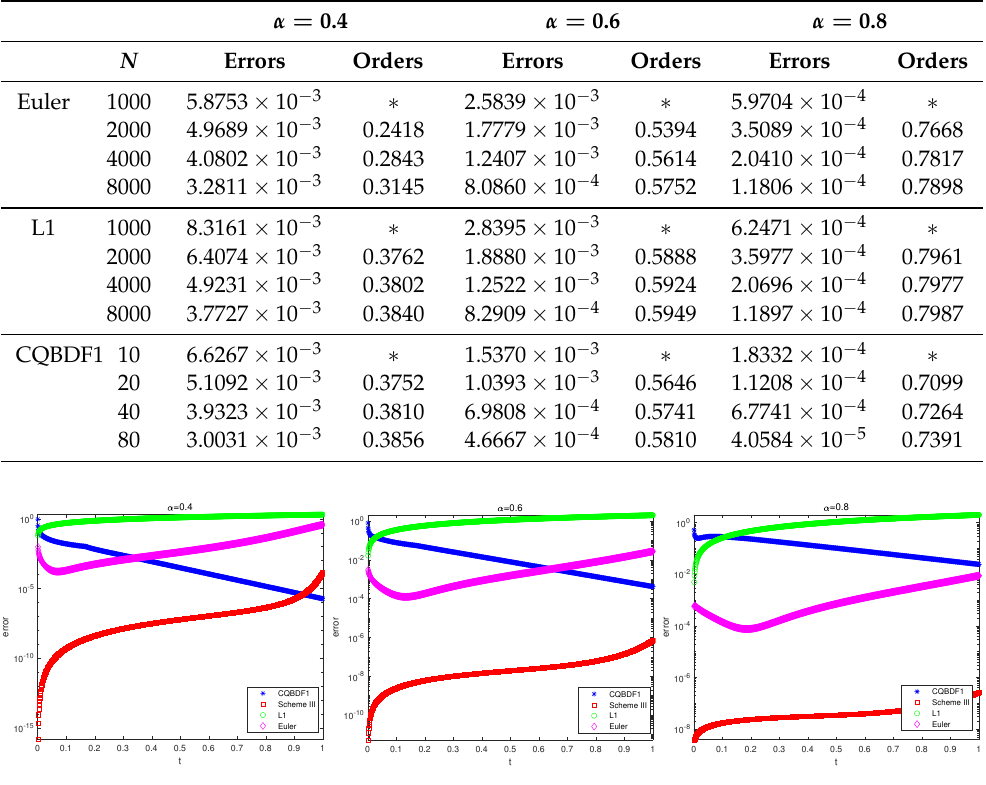
Figure 1. Evolution of maximum errors for different methods.